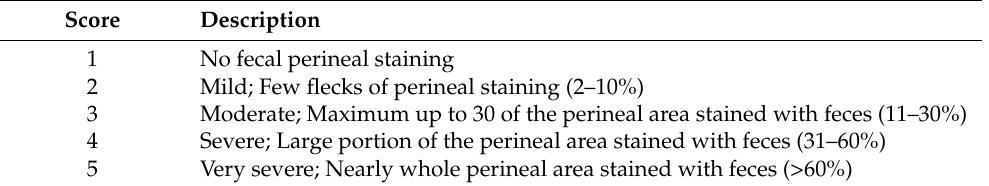
Table 3. Scoring of the fecal soiling of the perineal area in cattle. The percentage (in the brackets) refers to the proportion of the perineal area that is stained. Perineal area in this table refers to area around the anus, caudal hindlimb and rump, and